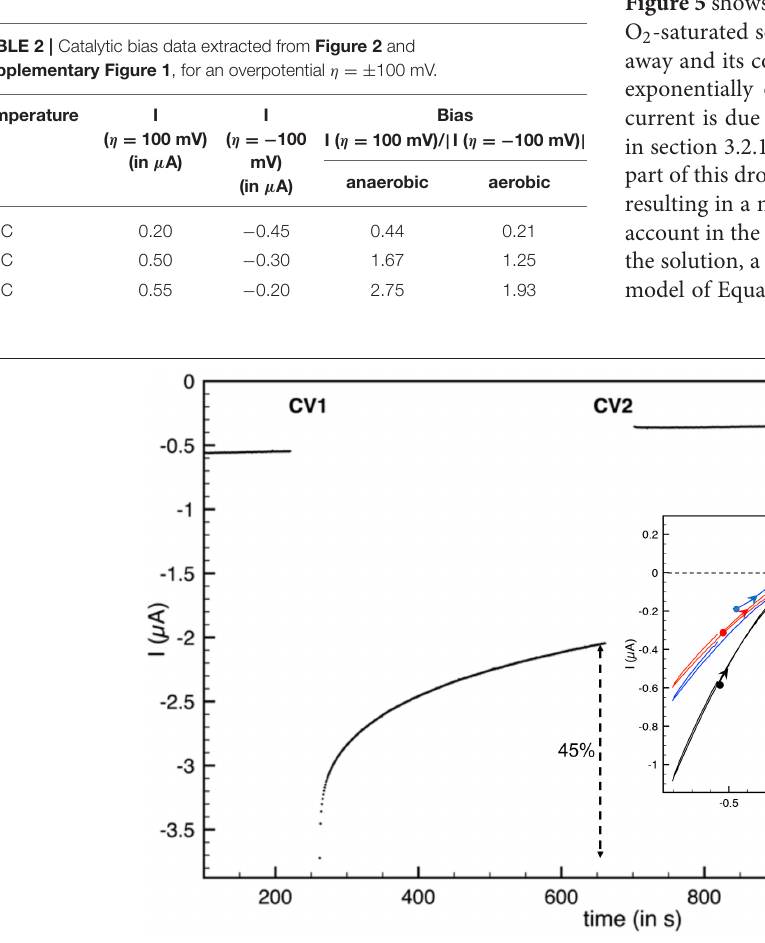
FIGURE 3 | Reductive inactivation of aerobically-purified Hnd hydrogenase adsorbed on PGE electrode. Main: chronoamperogram, E = − 510 mV vs. SHE for t < 250 s and t > 700 s and E = − 760 mV vs. SHE for 250 < t < 700s. Insert: cyclic voltammograms recorded after the first potential step (CV1, black line), after the second step (CV2, blue line), and after the last step (CV3, red line). The background current was subtracted. T = 30 ◦ C, 1 bar H 2 , phosphate buffer pH 7, ω = 3,000 rpm.